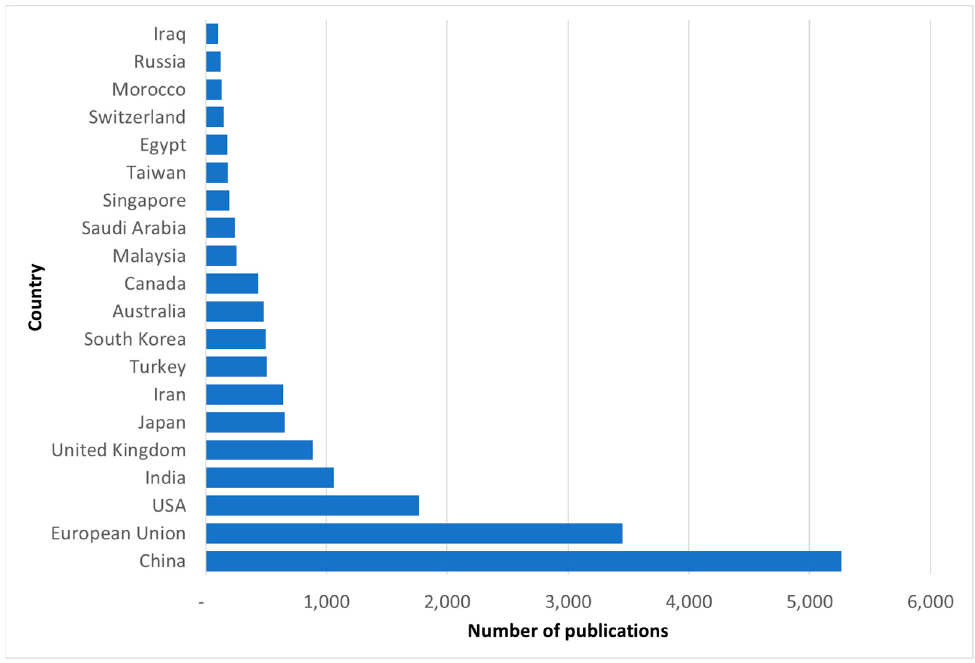
Figure 7. The number of publications in the field of TES materials field by country, with EU as a single category.